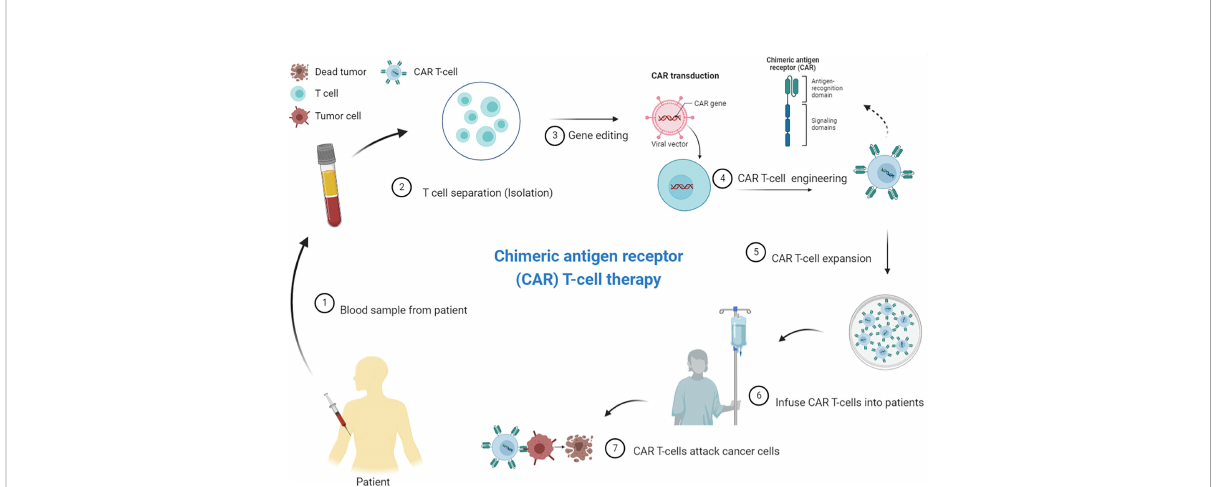
FIGURE 1 Principles of chimeric antigen receptor (CAR) T-cell therapy/CAR T-cell manufacturing process. CAR T-cell production includes normal T-cell extraction from the patient ’ s peripheral blood, followed by enrichment and CAR vector delivery, using viral or non-viral vector systems, into the T-cells in vitro . The CAR T-cells is subjected to expansion before being re-injected into the patient ’ s bloodstream. Patients usually receive a lymphodepletion before CAR T-cell administration to improve the expansion of adoptively transferred T-cells. The CAR T-cells proliferate and attack tumor cells that carry the speci fi c antigen against which the CARs are directed (Source: Author ’ s personal collection, 2021). Created with